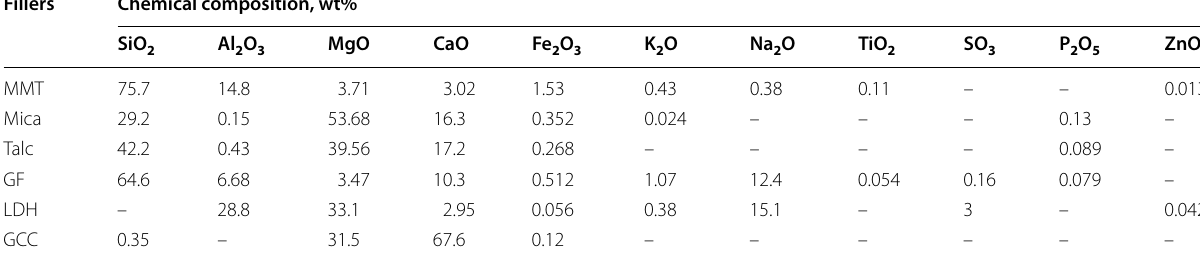
Table 1 Chemical composition of inorganic fillers.